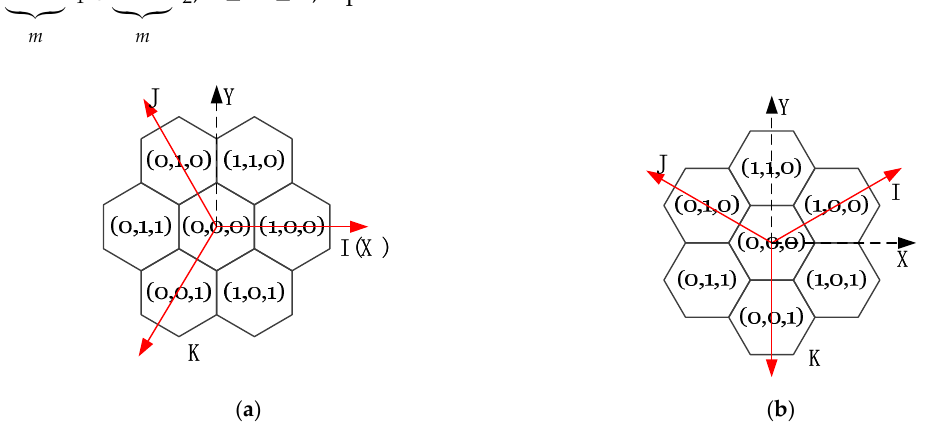
Figure 9. The IJK coordinate system defined for mixed aperture 3 and 4 hexagonal grids: ( a ) is used